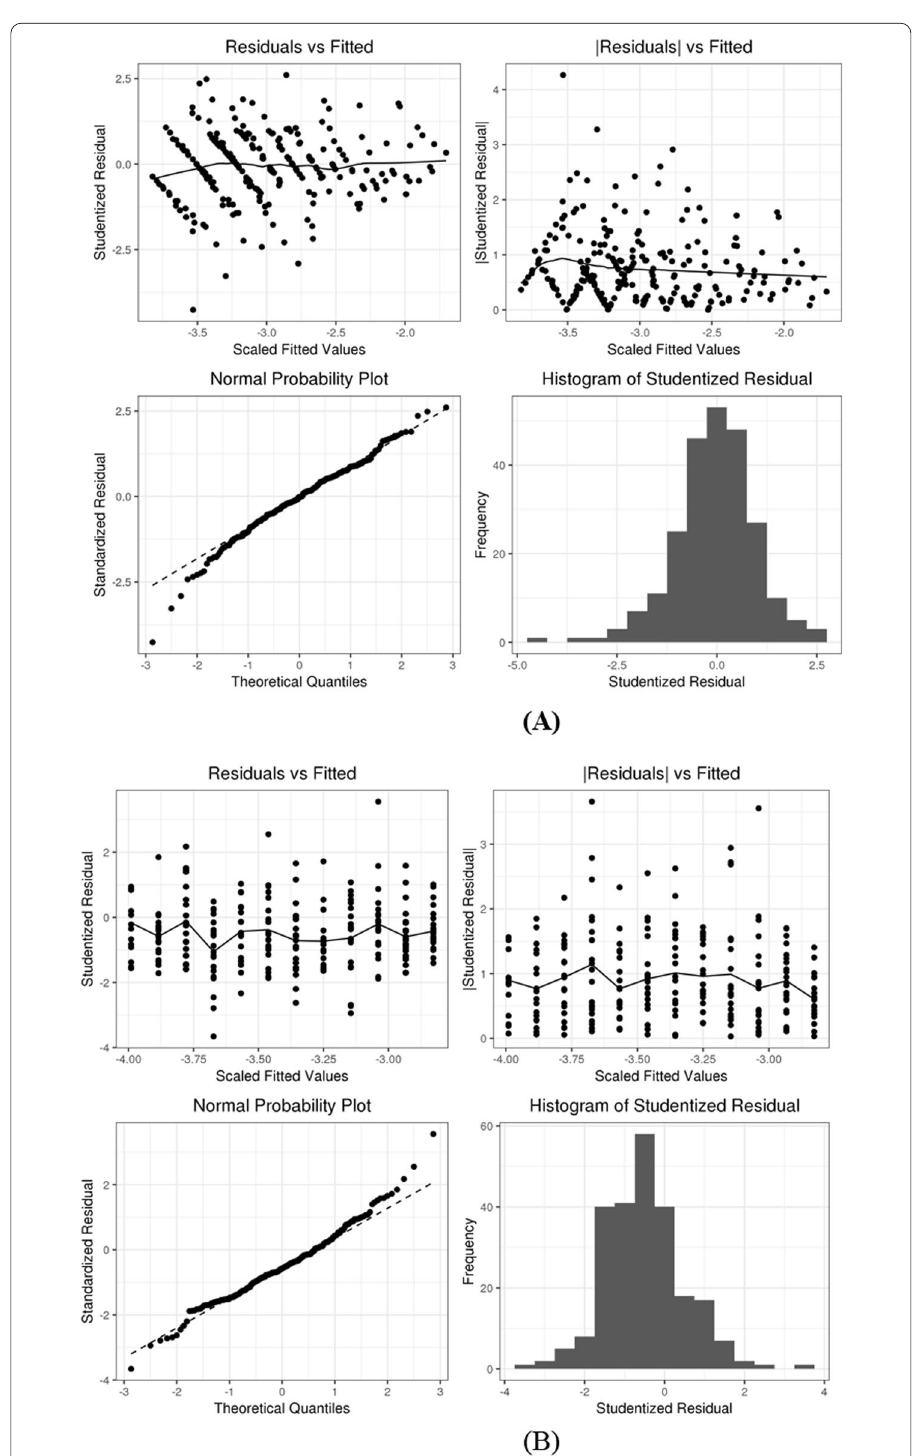
Fig. 5 Model checking plots of DHGLM for mean ( A ), and model checking plots of DHGLM for dispersion ( B